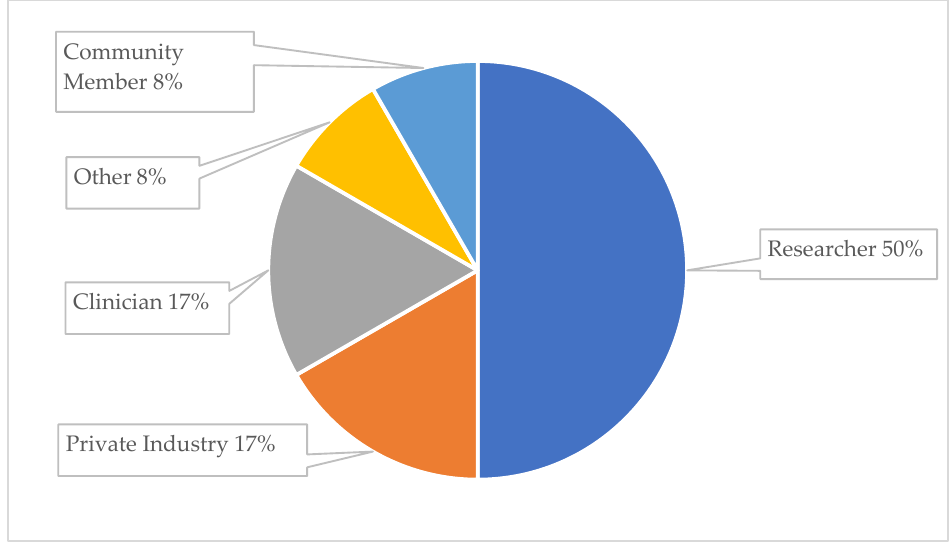
Figure 1. Capacity in which the survey respondents attended the Why Study Mammographic Den ‐ sity Conference.